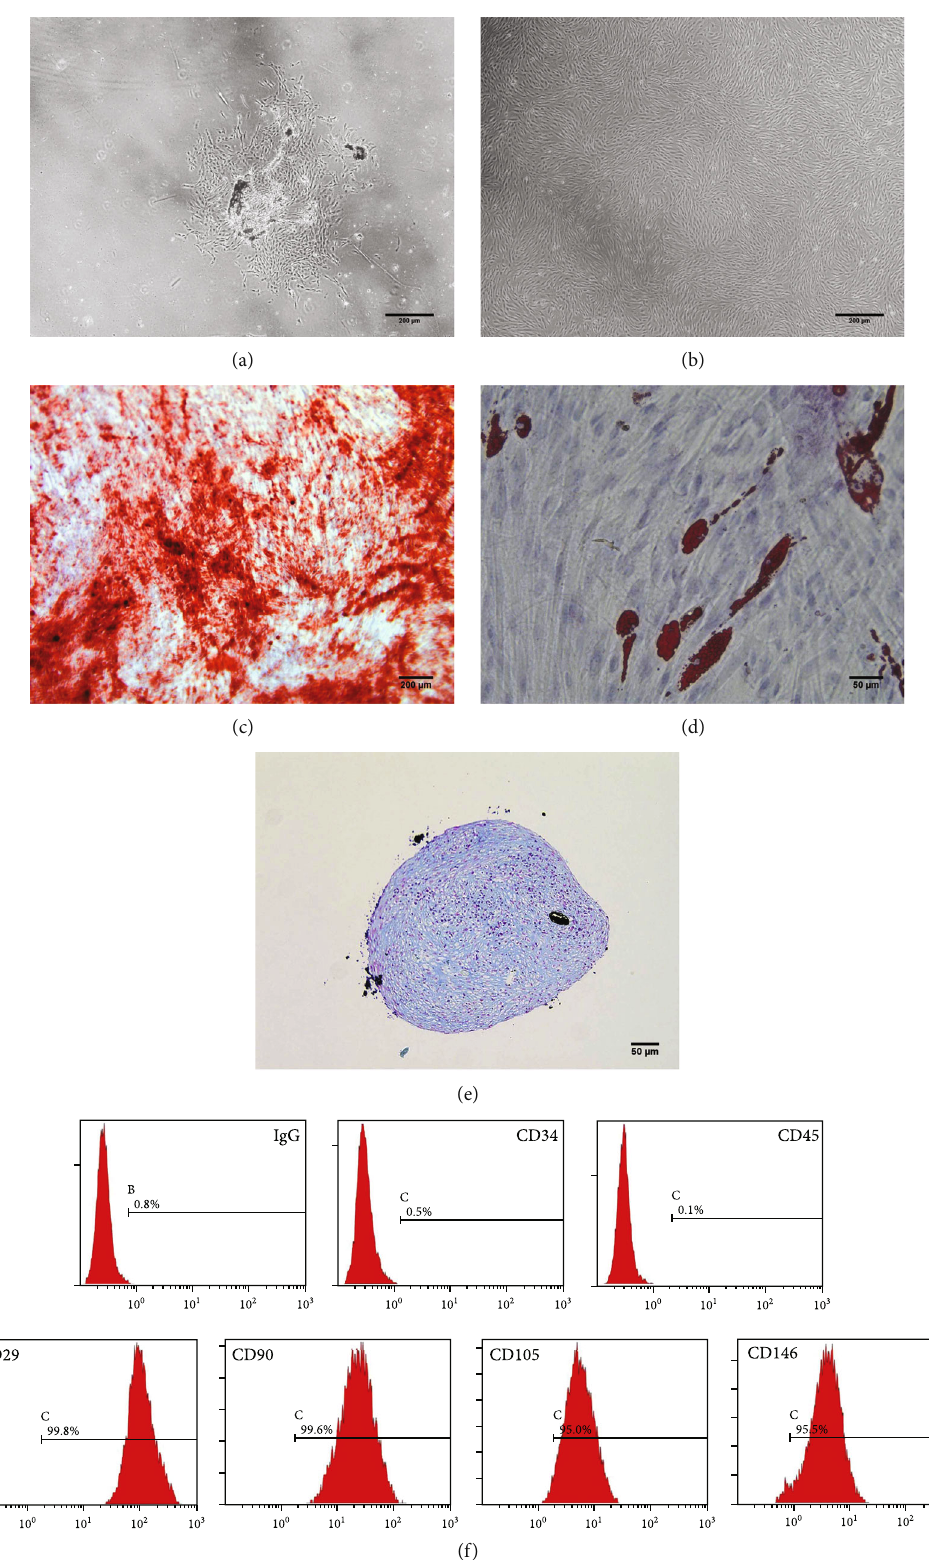
Figure 1: Characterization of DPSCs. (a) Primary DPSCs cultures on day 5 (40 × ). (b) DPSCs at passage 3 exhibit a spindle-shaped morphology (40 × ). (c) Mineralized nodules in DPSCs cultures stained with Alizarin Red S (50 × ). (d) Oil Red O staining for lipid droplets in DPSCs cultures (200 × ). (e) Alcian blue staining indicates synthesis of proteoglycans by chondrocytes (100 × ). (f) Molecular surface marker expression in DPSCs by fl ow cytometry. DPSCs: dental pulp stem cells. Scale bars are